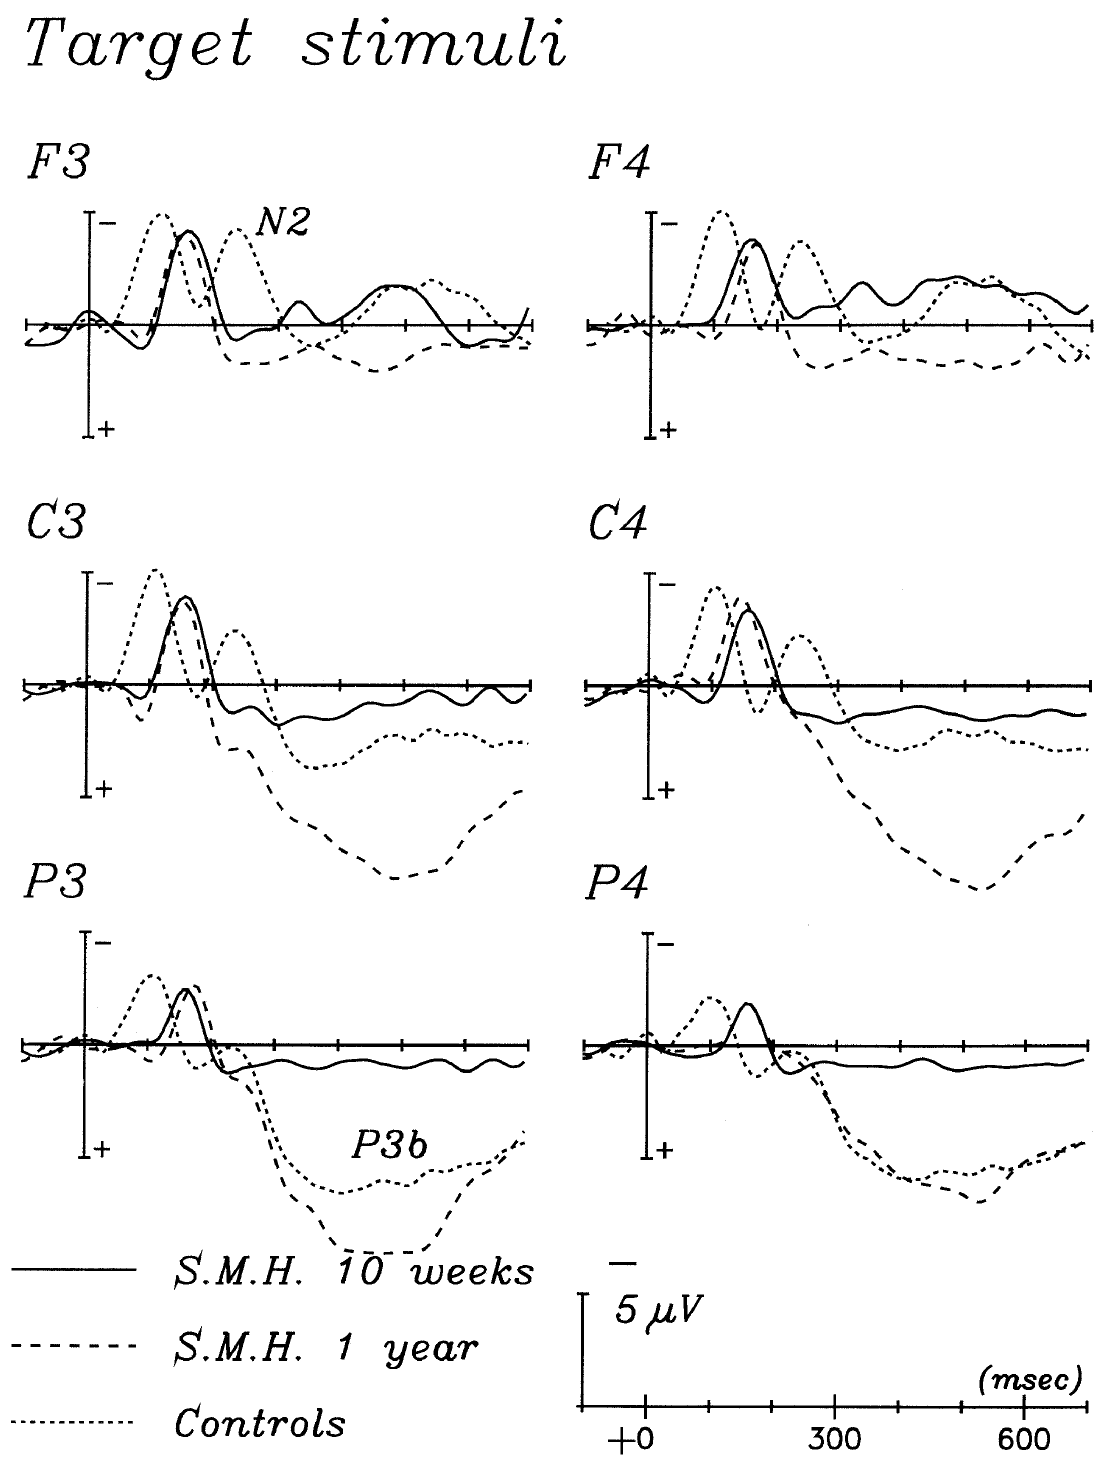
Fig. 6. Auditory event-related N2- and P3b-potentials to detected targets. The patient’s P3b is absent 10 weeks after the stroke but returns 1 year